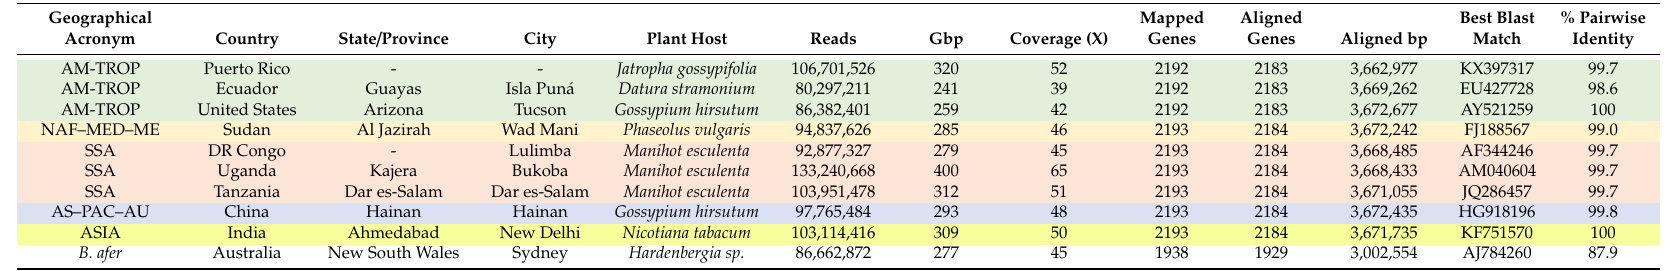
Table 2. Summary of collection information and genomic coverage for each individual sequenced. The last column (% Pairwise Identity) corresponds to the best BLAST hit match from the Megablast search of COI data obtained from read-mapping. Plant host indicates the scientific name of the plant the sample was collected. The color of rows corresponds to the putative species suggested by ABGD